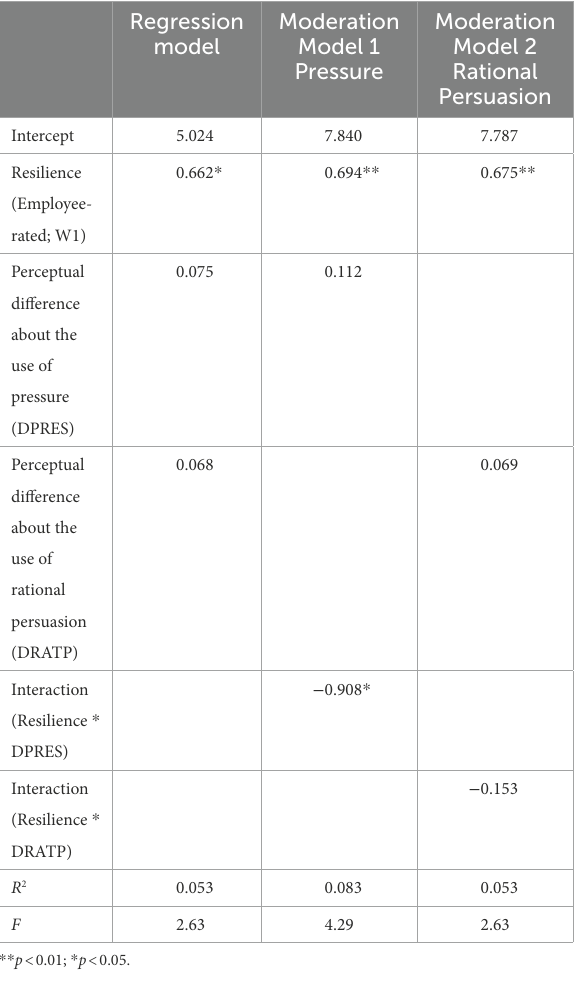
TABLE 2 Moderation analysis with workability as dependent variable (employee-rated; W2; n = 146).